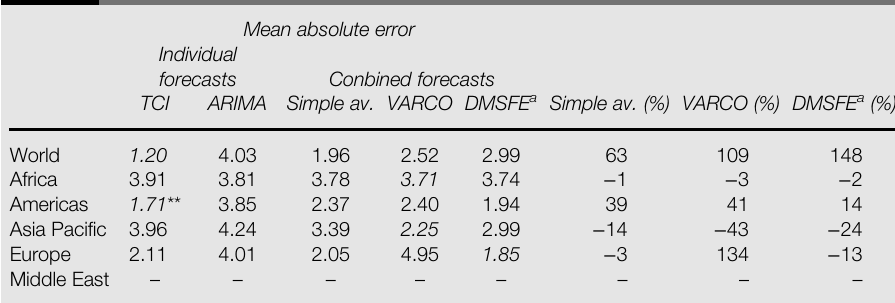
Table IV Mean absolute error, concordance statistics and accuracy tests – crisis scenario